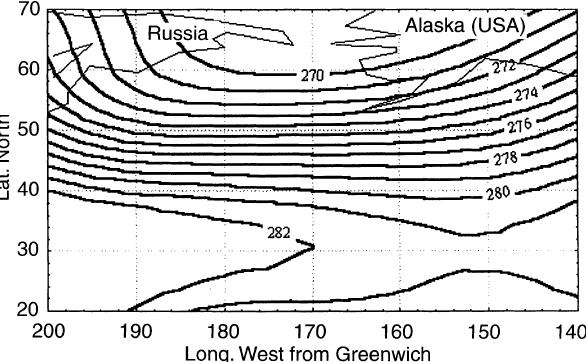
Fig. 5. Temperature pattern (in (cid:14) K) in July 1971 over the North Pacific area. Characteristic situations, among those analysed, repre- senting minimum contribution in this month for the seventh term